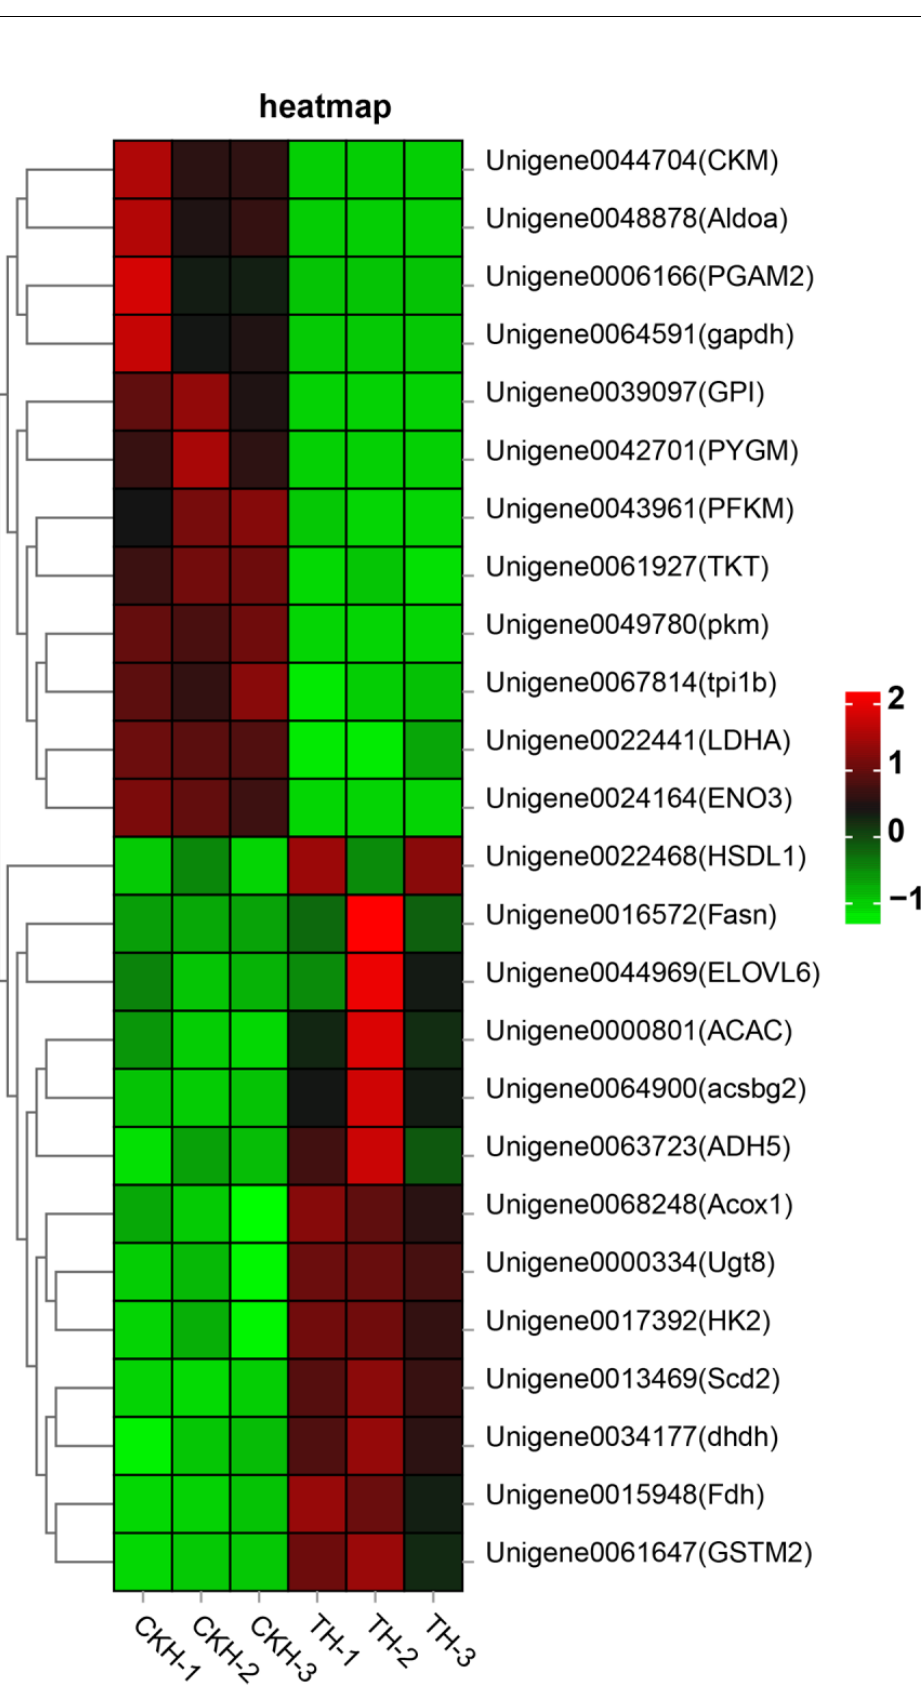
Figure 3. Heatmap of significantly differentially expressed genes involved in metabolism pathways after EHP infection.